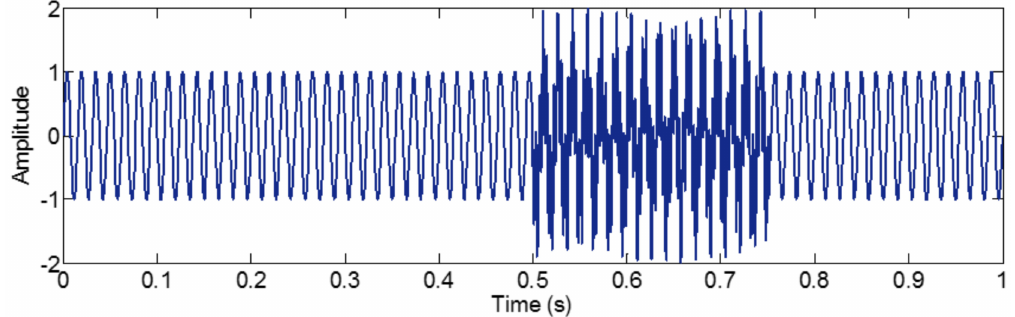
Figure 19. The waveform of the sample signal f sig 4